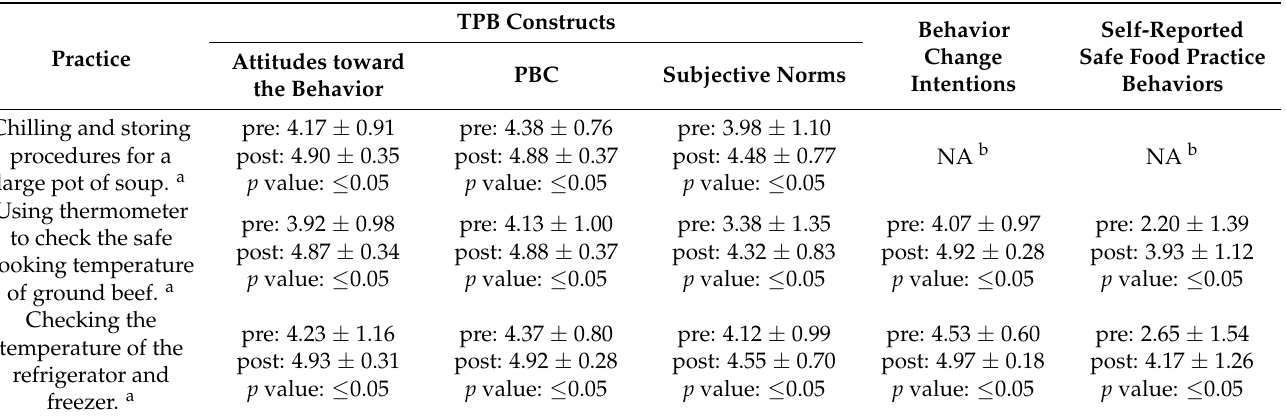
Table 4. Food safety practices with a significant improvement in the TPB constructs, behavior change intentions, and self-reported safe food practice